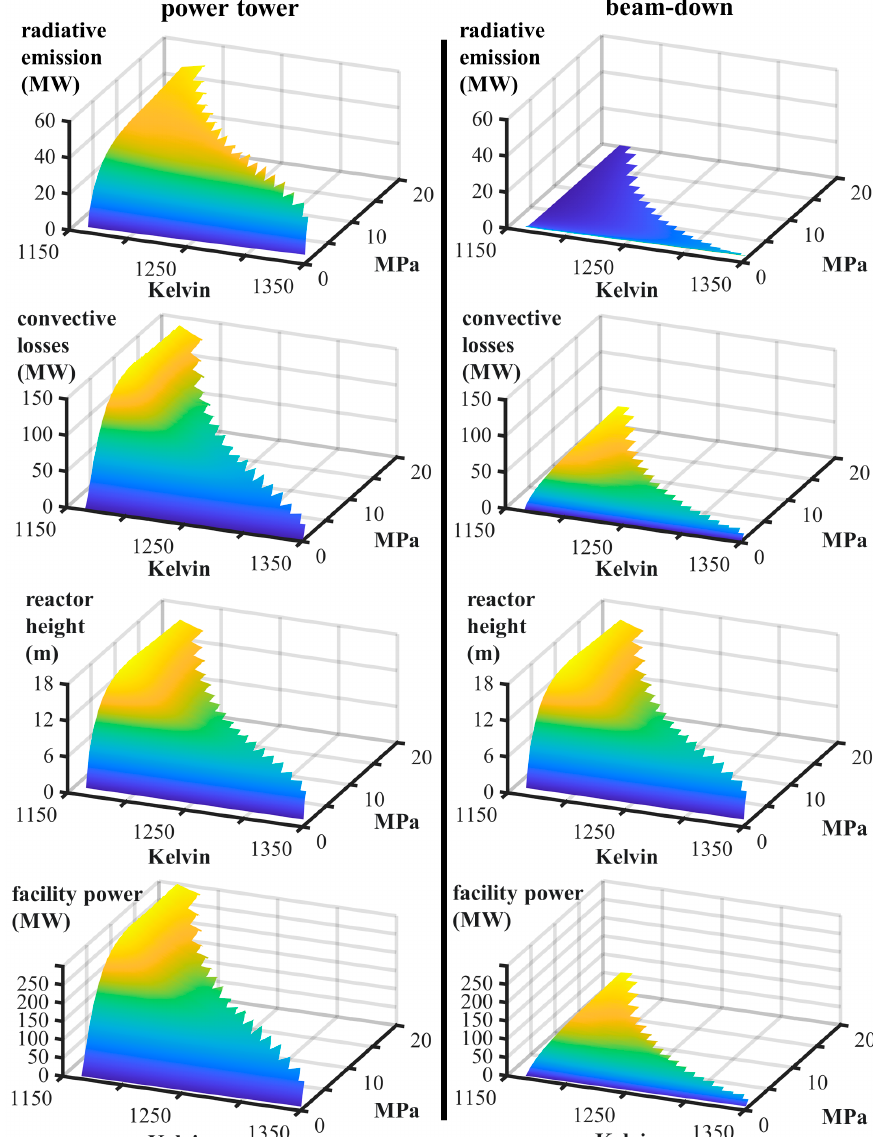
Figure 7. Losses and their contributing factors in alternative solar facilities for H 2 production.